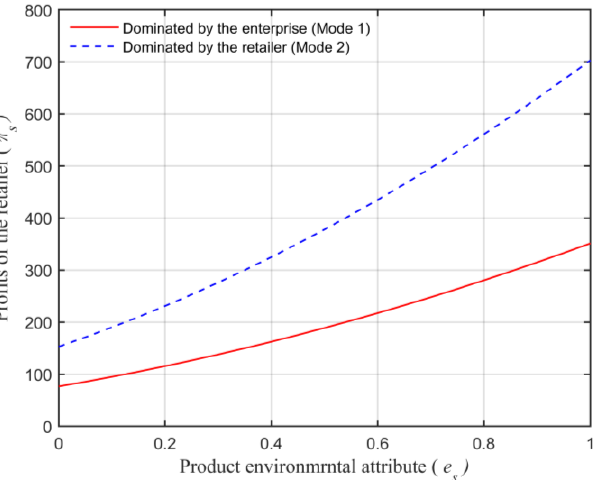
Animals 2023 , 13 , x FOR PEER REVIEW Figure 6. The relationship between the product environmental attribute and the product demand.